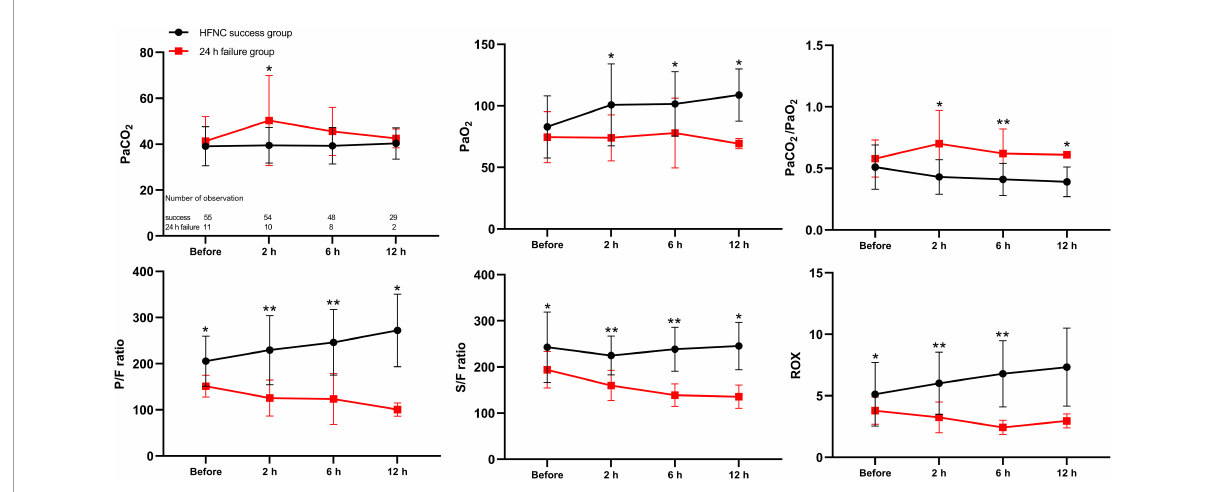
FIGURE3 Time-course changes of arterial blood gas analysis before and 2, 6, and 12 h after high-flow nasal cannula treatment onset as mean (SD) in the prospective cohort. CI, confidence interval; PaCO 2 , arterial partial pressure of carbon dioxide; PaO 2 , arterial partial pressure of oxygen; PaCO 2 /PaO 2 , arterial partial pressure of carbon dioxide-to-arterial partial pressure of oxygen; P/F ratio, arterial partial oxygen pressure-to-fraction of inspired oxygen ratio; S/F ratio, percutaneous oxygen saturation-to-fraction of inspired oxygen ratio; ROX, ratio of percutaneous oxygen saturation and fraction of inspired oxygen to respiratory rate. * P < 0.05; ** P < 0.001.